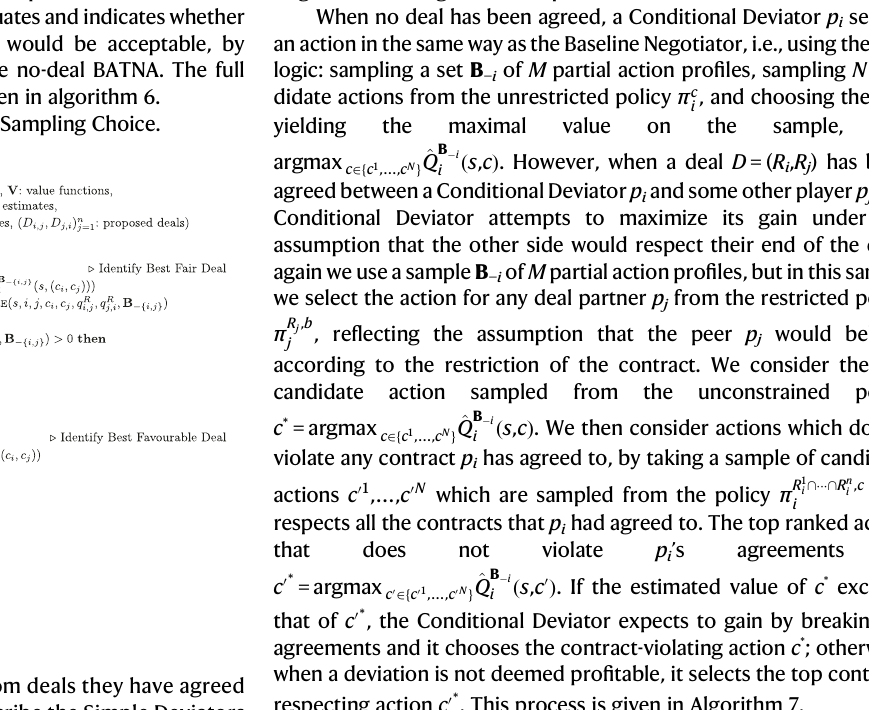
Algorithm 7 Conditional Deviator Action Selection for p i